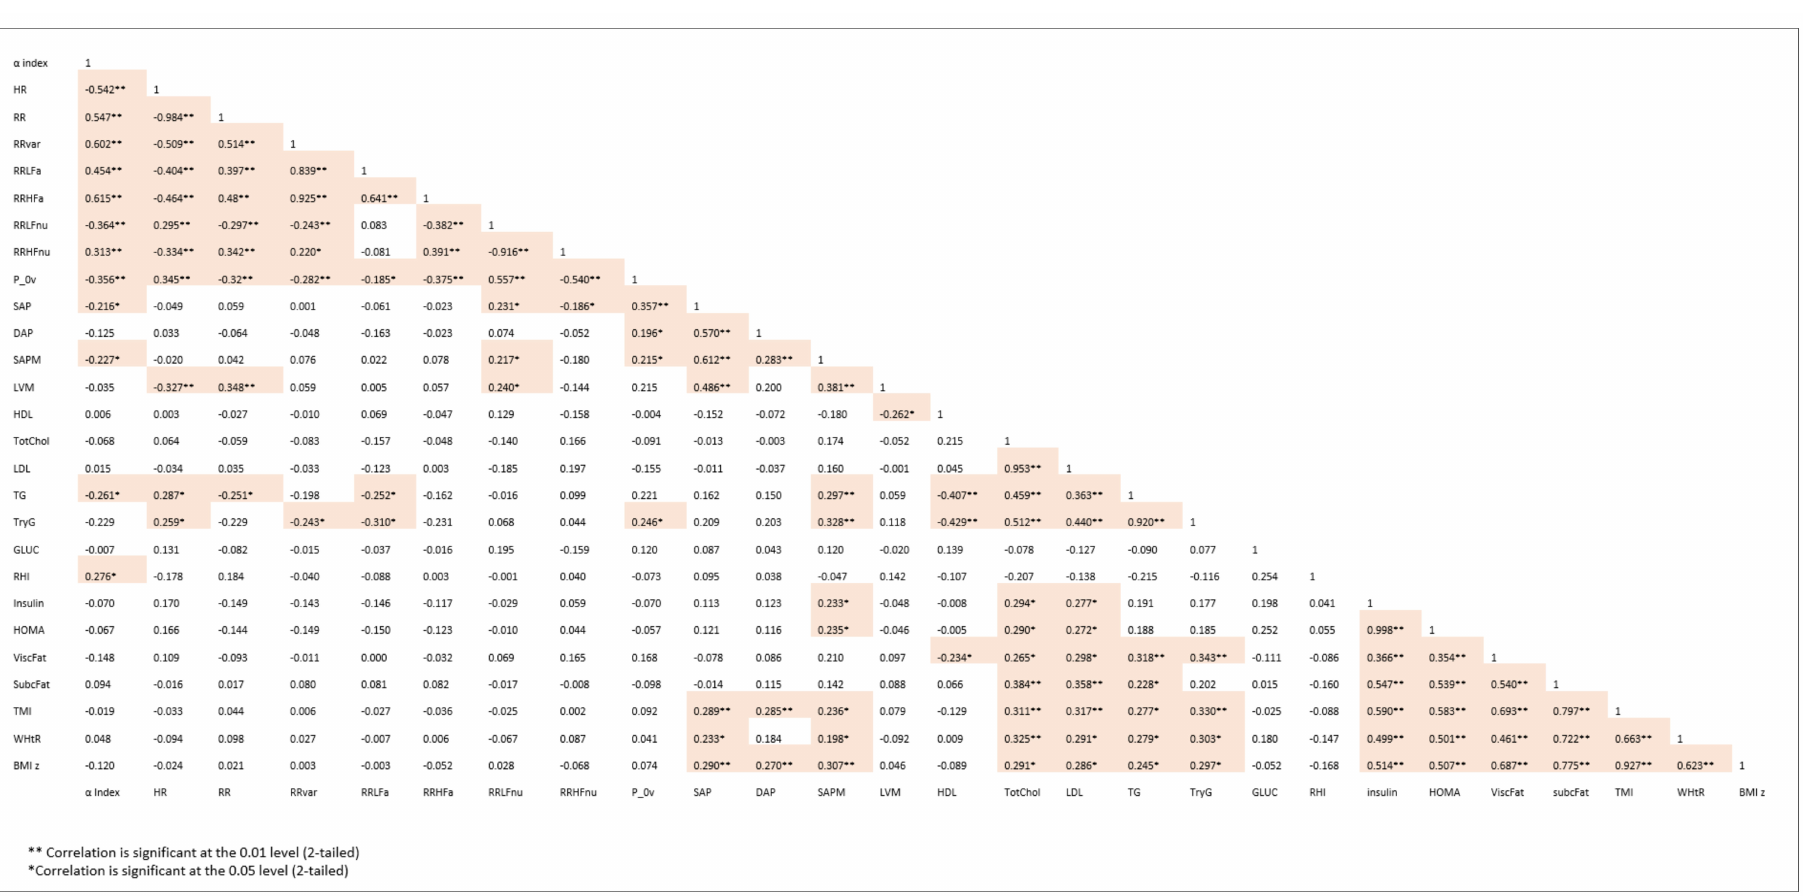
Figure 1. Correlation matrix between major autonomic and metabolic/hemodynamic